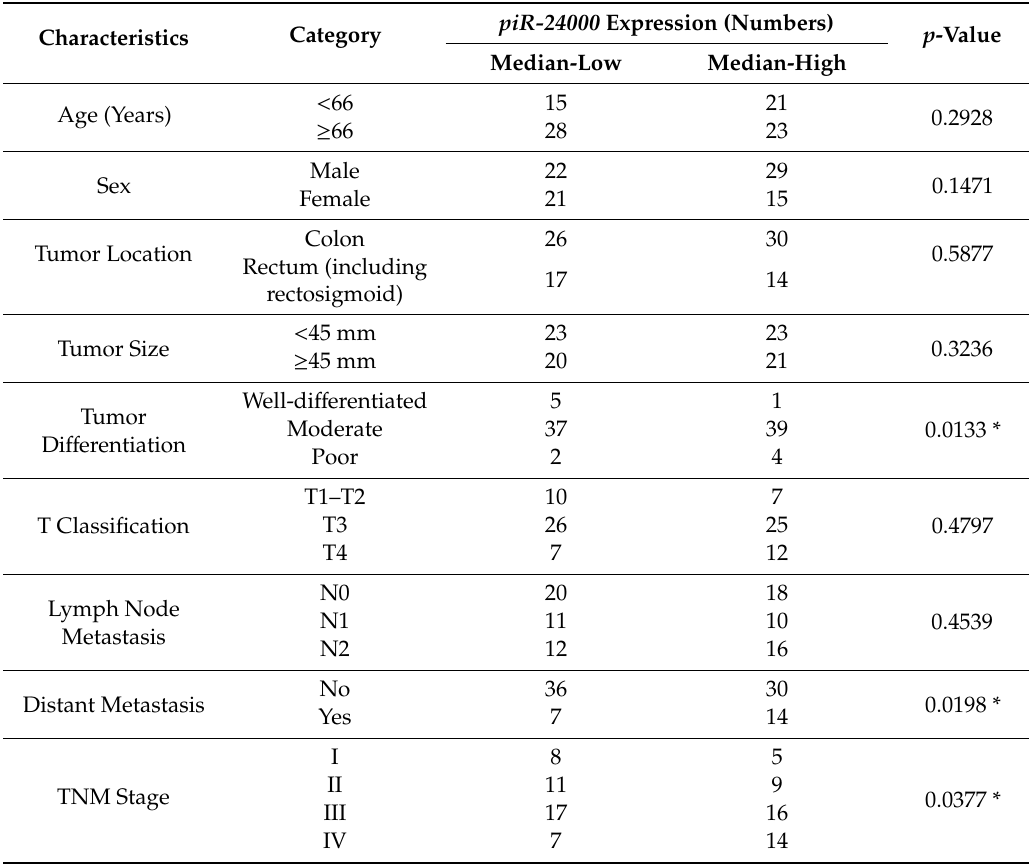
Table 2. Correlation between clinicopathological features and piR-24000 expression in 87 colorectal cancer